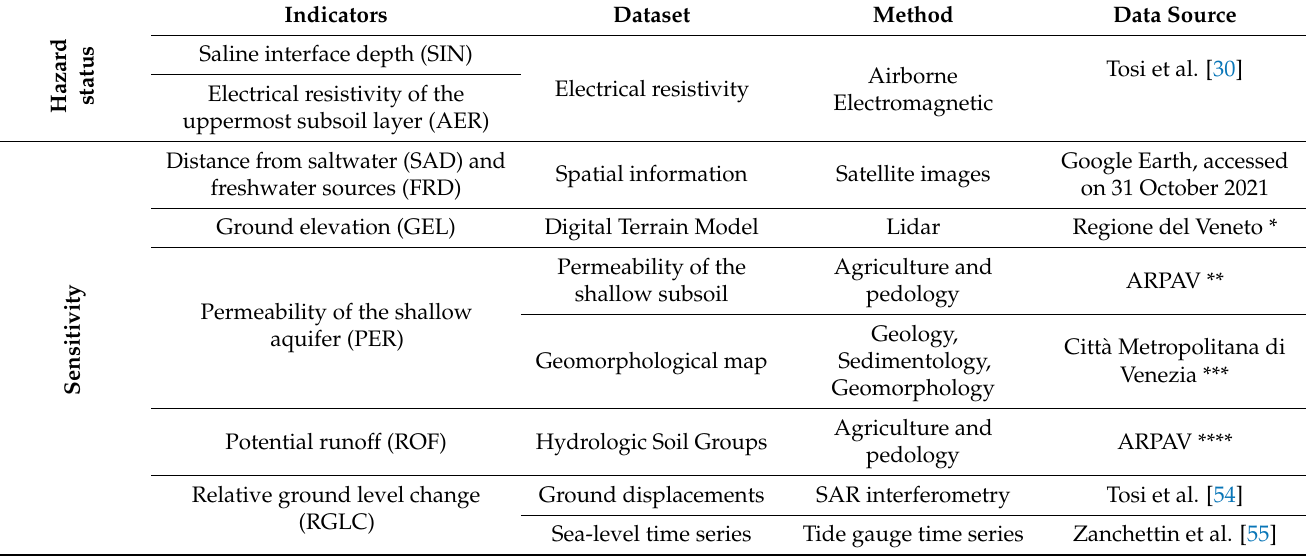
Sensitivity/hazard status indicators and available dataset used in the vulnerability